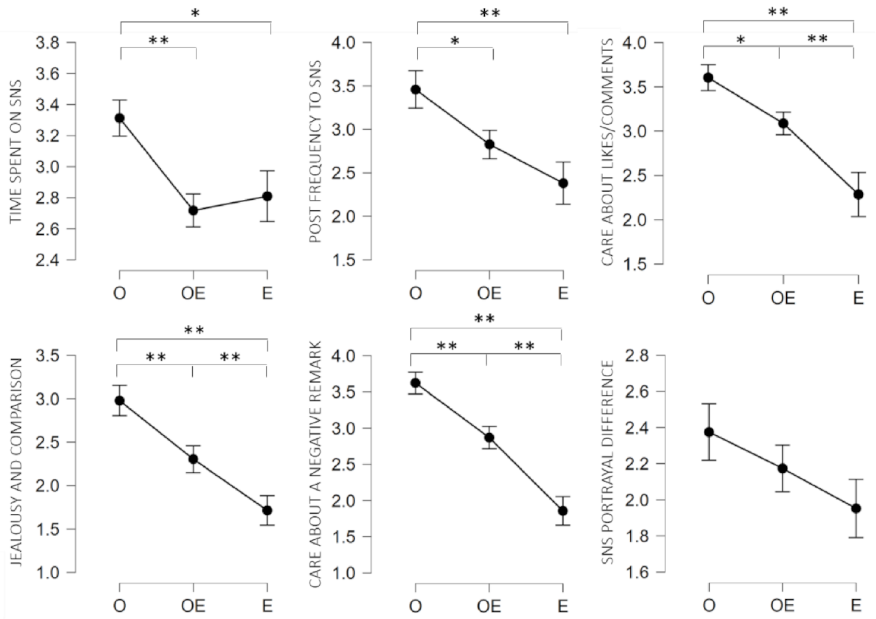
Figure 1. Charts to show social media response separated by Oversensitive (O), equal (OE), and Egocentric (E) phenotypes of vulnerable narcissism. Error bars represent standard error of the mean; * p < 0.05, ** p <